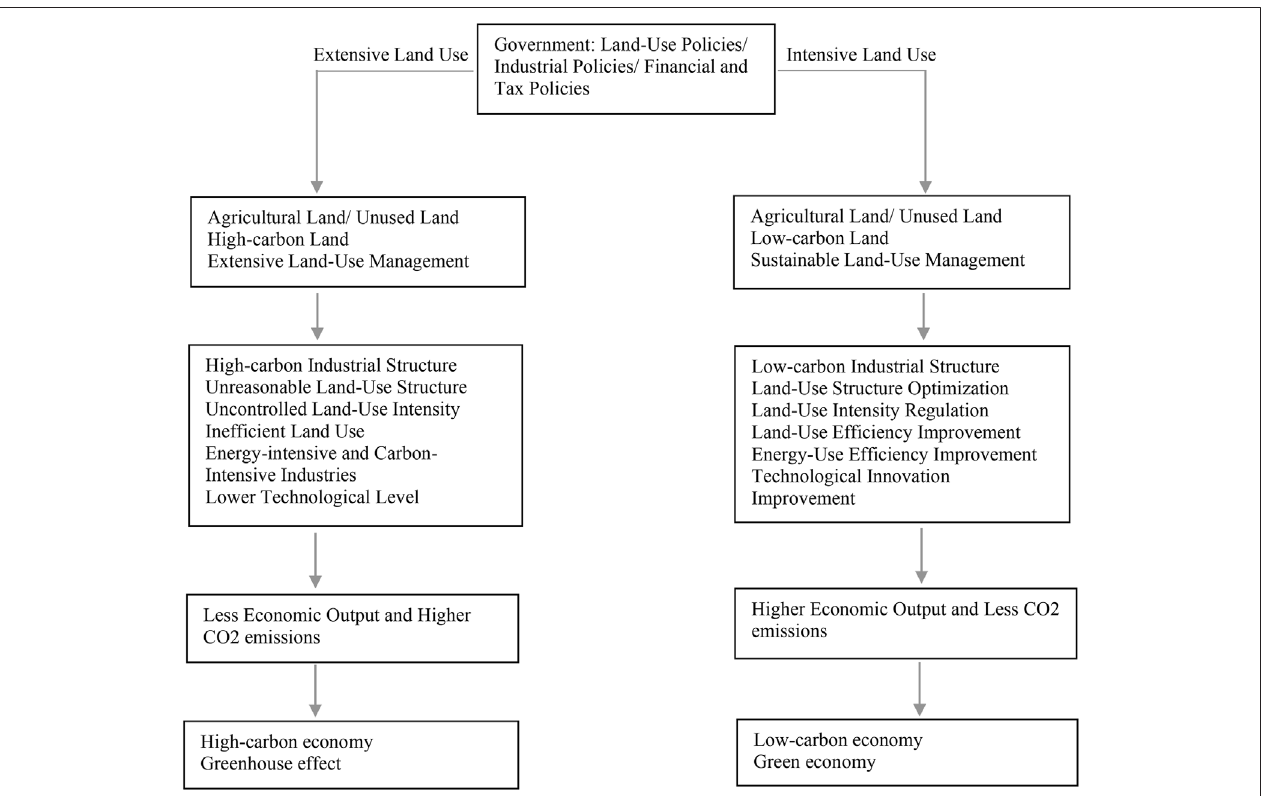
FIGURE 1 | Diagram of the in fl uence mechanism between land urbanization and CO 2